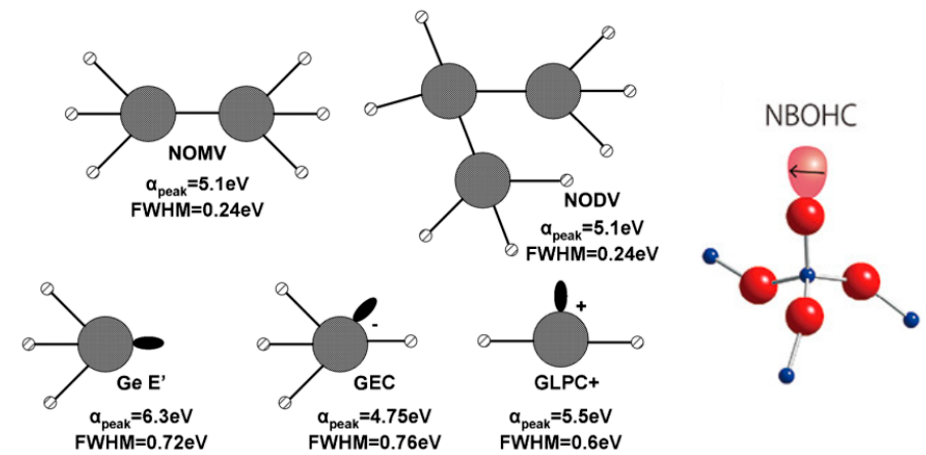
Figure 6. Various germanate defects with values of α and FWHM provided for each center correspond to position of the maximum and full width at half maximum of the absorption peak associated with the defect. Modified from [61,69].